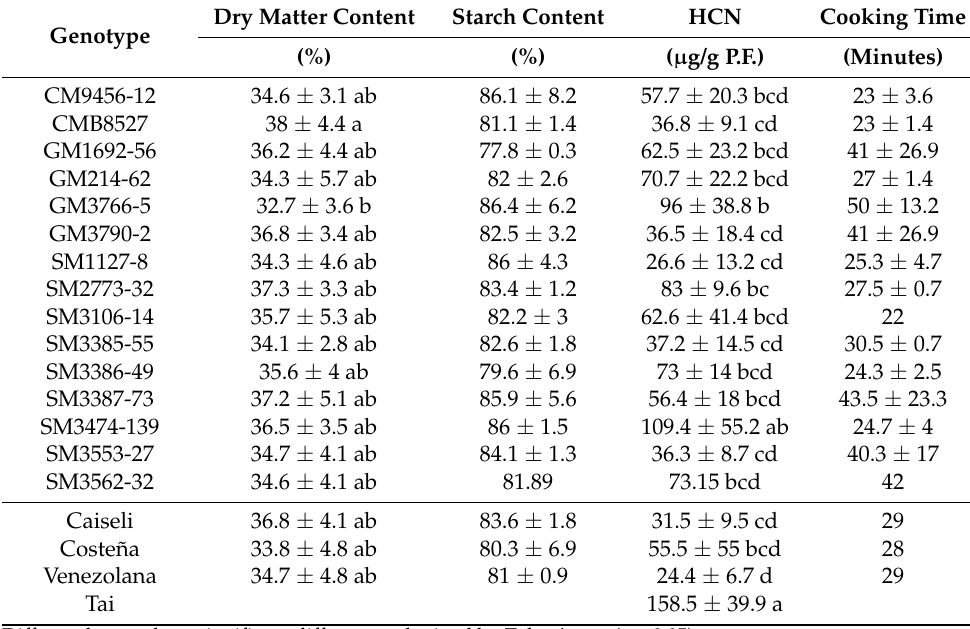
Table 8. Quality features of the evaluated cassava genotypes. Genotype